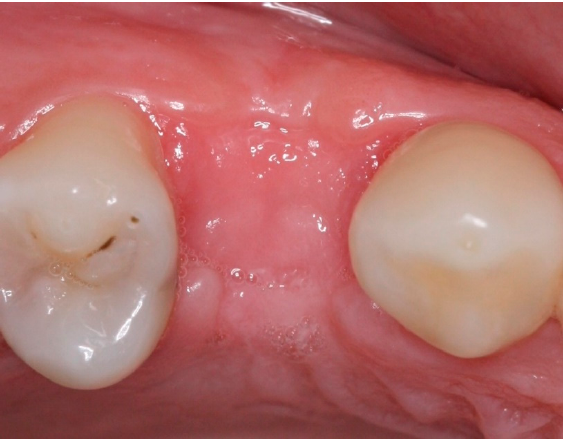
Figure 15. Intraoral occlusal view of TG1, four months after the procedure.